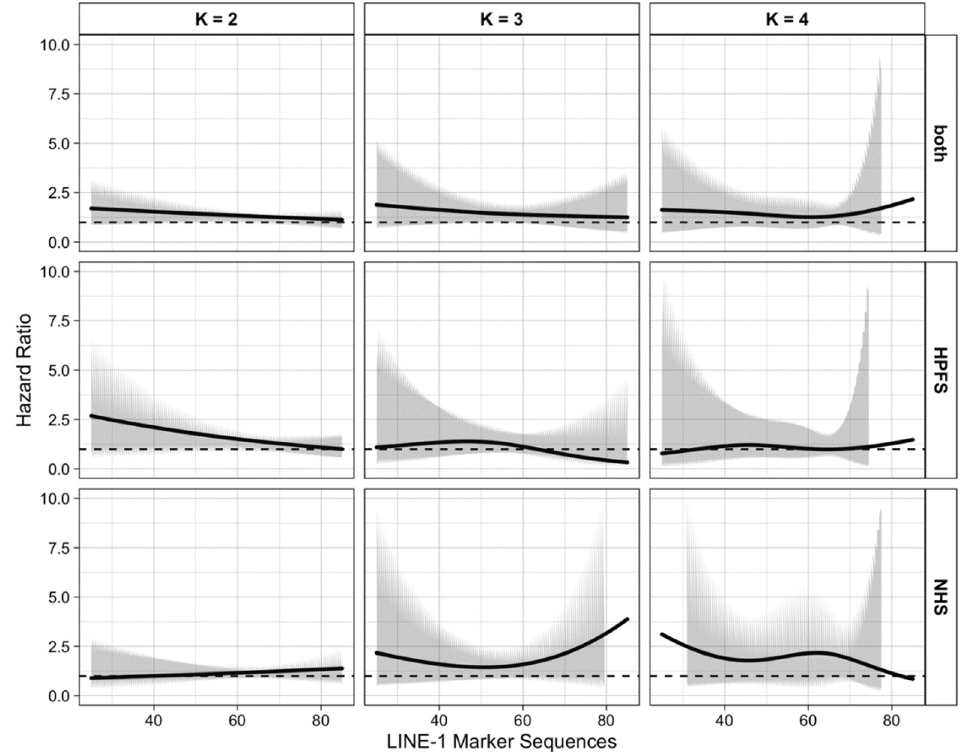
Figure 1. Heterogeneous Effect of Cumulative Categorical Alcohol Intake (>15 g/day vs. 0 g/day) on continuous subtypes of colorectal cancer; the 3 × 3 plot panel illustrates the combination of three choices of the knot number in 𝑔(𝜙, 𝑍) and three cohort settings. Abbreviations: HPFS, Health Pro- fessionals Follow-up Study; LINE-1, long interspersed nucleotide element-1; NHS, Nurses’ Health Study.